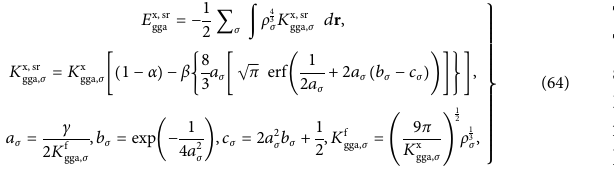
LC- CAM- CAM- PBE0 LC- LC- CAM- BLYP BLYP ot B3LYP B3LYP ot PBE PBE ot PBE0